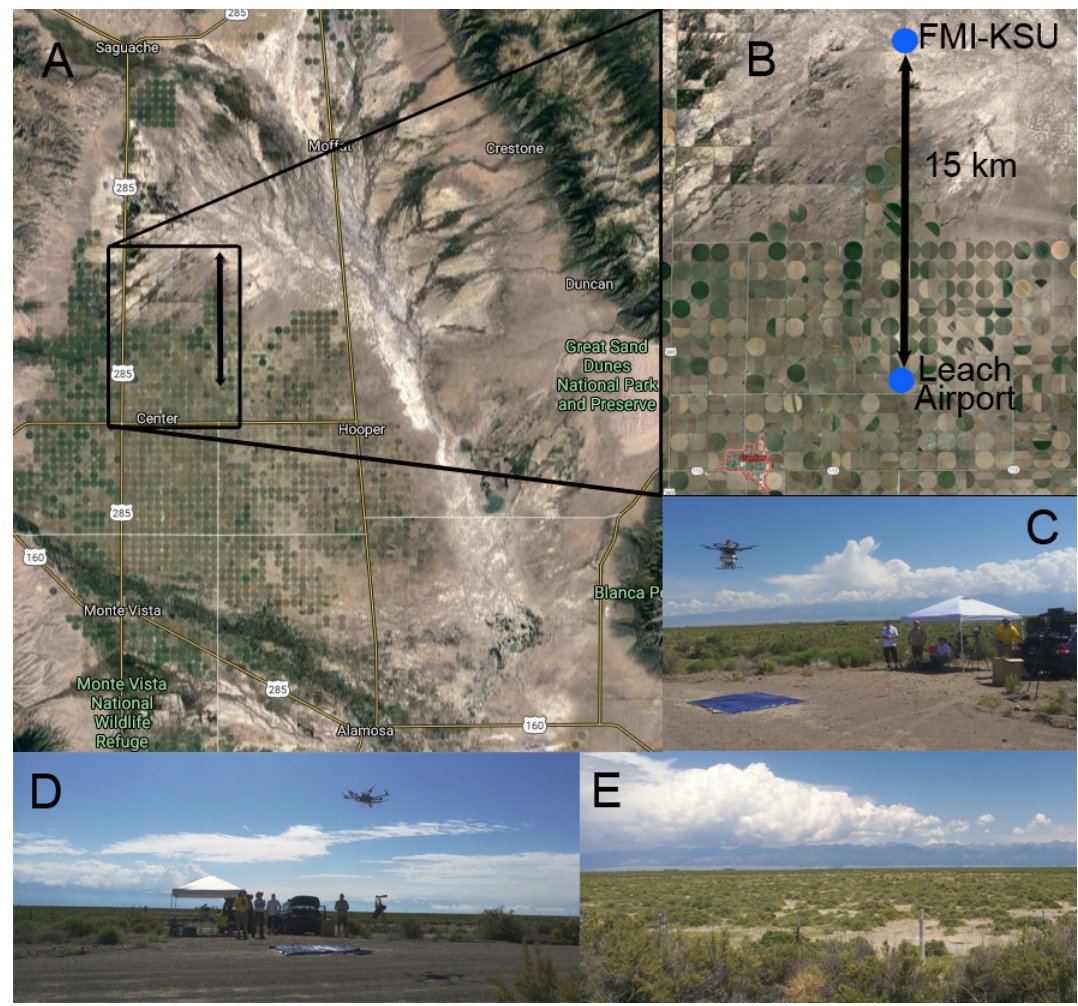
Figure 1. (a) Map of the wider San Luis Valley, CO, and (b) map cutout of FMI-KSU team location – 15km N of Leach airport, located approximately 3.2km ENE of the commercial district of Center, Colorado, and 32km NNW of Alamosa, Colorado. © Google Maps (c) FMI- KSU team operation spot NE view, (d) FMI-KSU team operation spot view towards E, (e) view of typical surroundings of FMI-KSU team